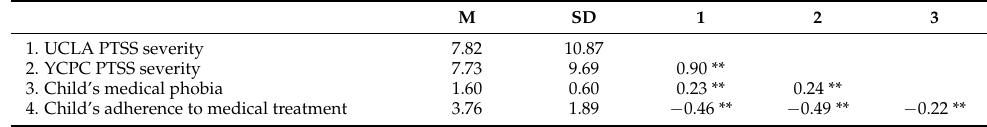
Table 2. Means, standard deviations and Pearson correlations between main study